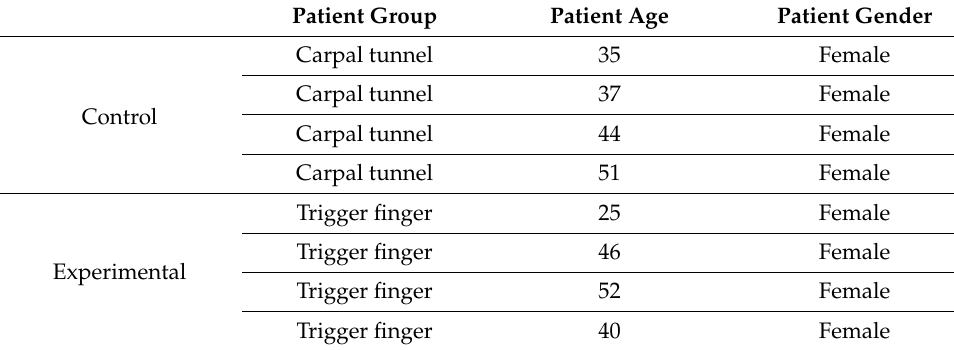
Table 1. Characteristics of Patients used for tissue